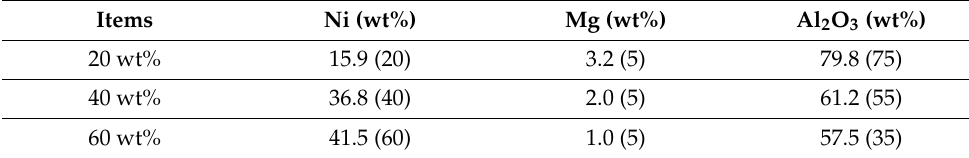
Table 4. SEM-EDX analysis results for fresh Ni-Mg-Al catalysts